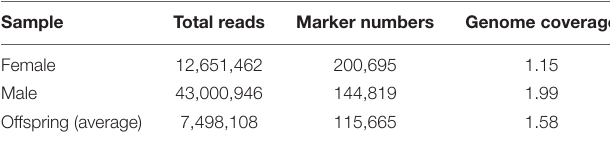
TABLE 3 | Summary of sequence data of parents and